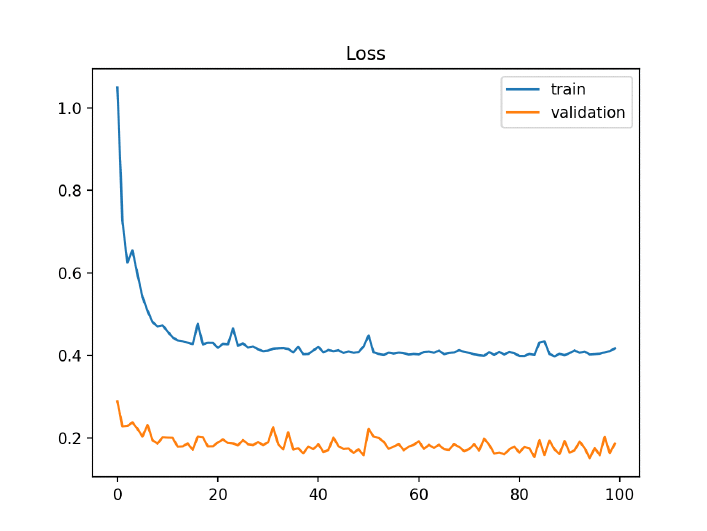
Fig. 4 The overall loss curve of the model.